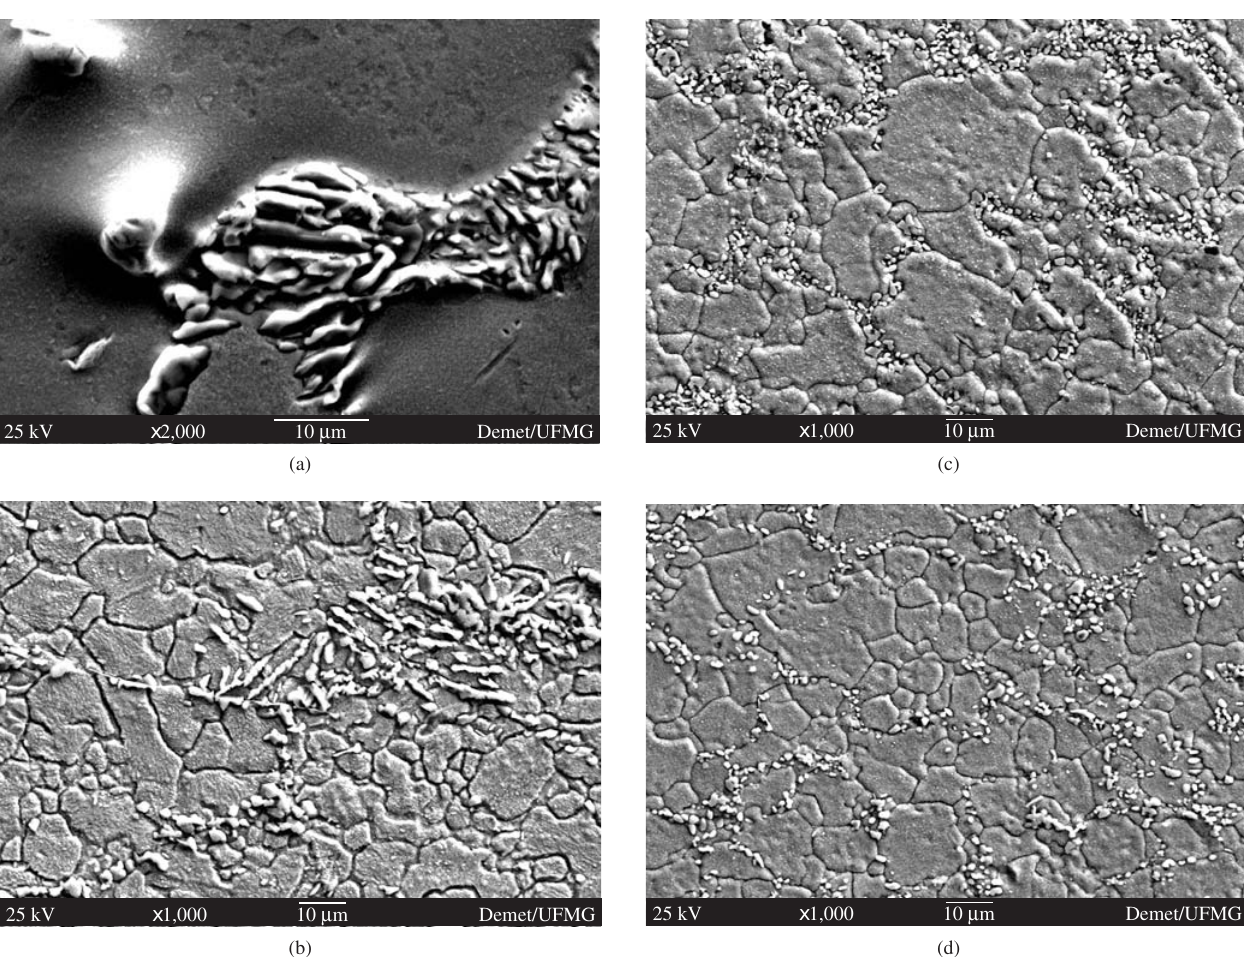
Figure 7. Antimony precipitates evolution during ECAP: a) As-cast alloy; b) After 1 pass; c) after 2 passes; and d) after 8